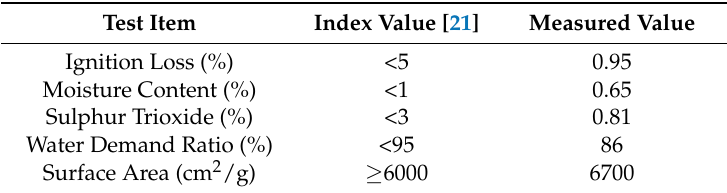
Table 2. The technology indicators of fly ash in the Zouxian power